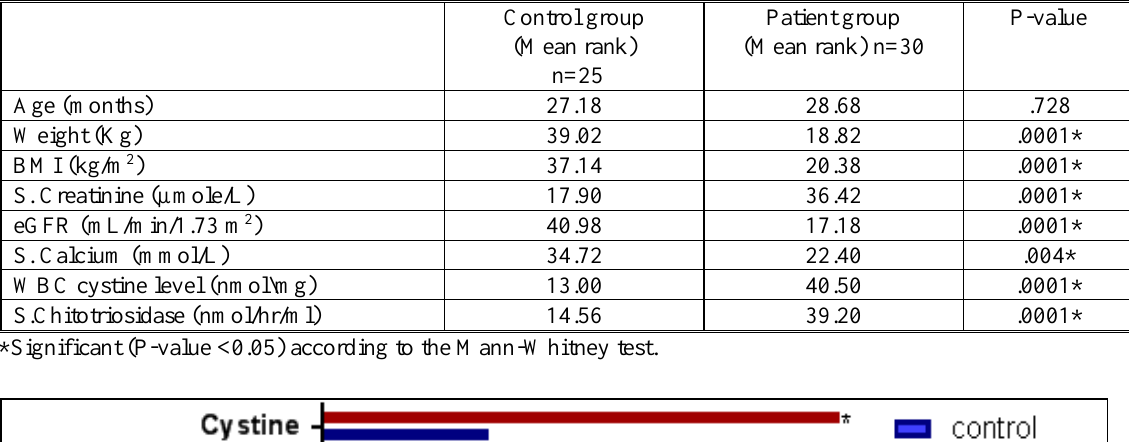
Table 3. The difference between patient and control groups.